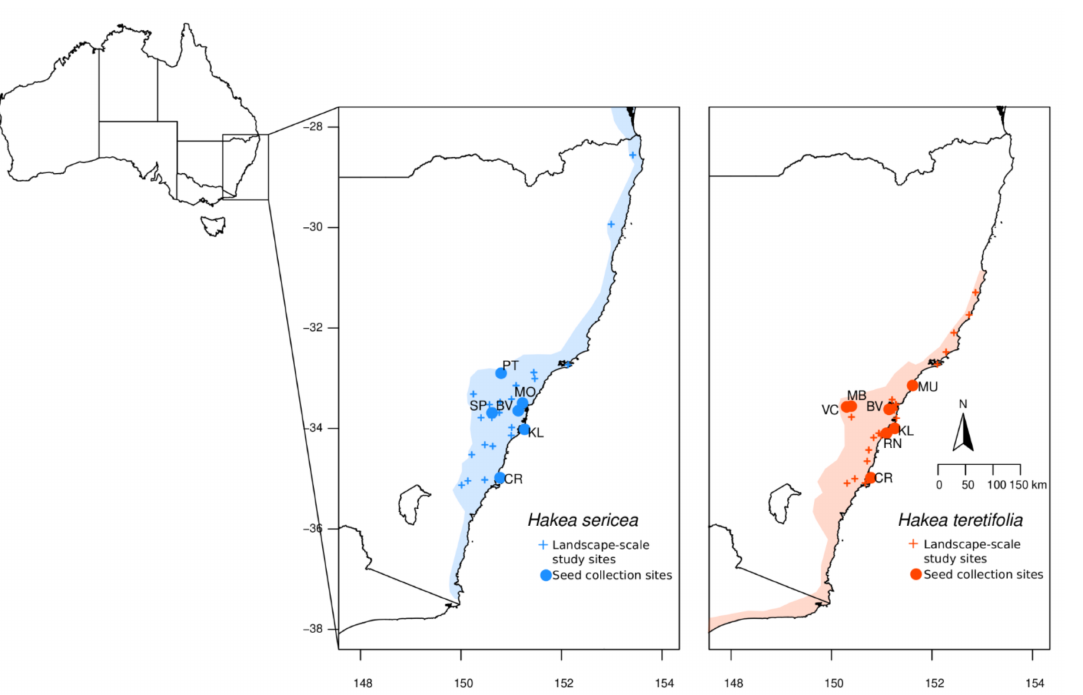
Figure 1. Maps showing distribution range of study species (shading), sites sampled for landscape- scale evaluation of genetic diversity (+), and sites sampled for progeny analysis ( • and site code).